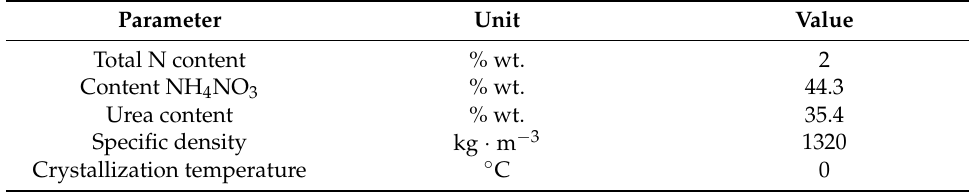
Table 1. Urea ammonium nitrate solution (RSM).